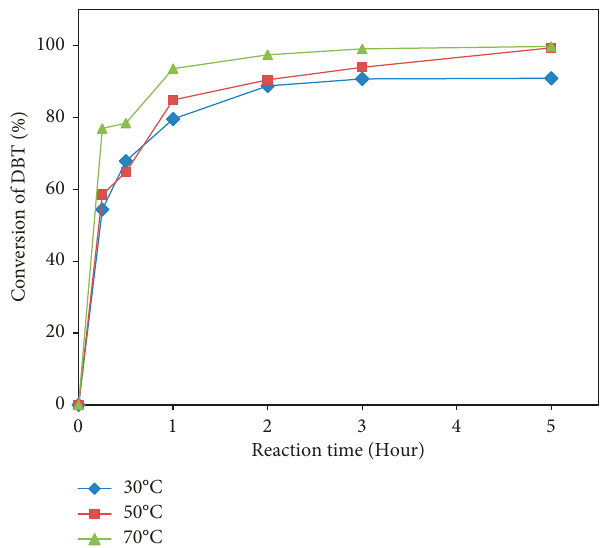
Figure 9: Conversion of DBT under UV at various reaction temperatures. Experimental conditions: V (model fuel) � 20 mL, m � 0.05g, and V � 0.5 mL. Al − MCM − 41@01Ag / TiO 2 H 2 O 2